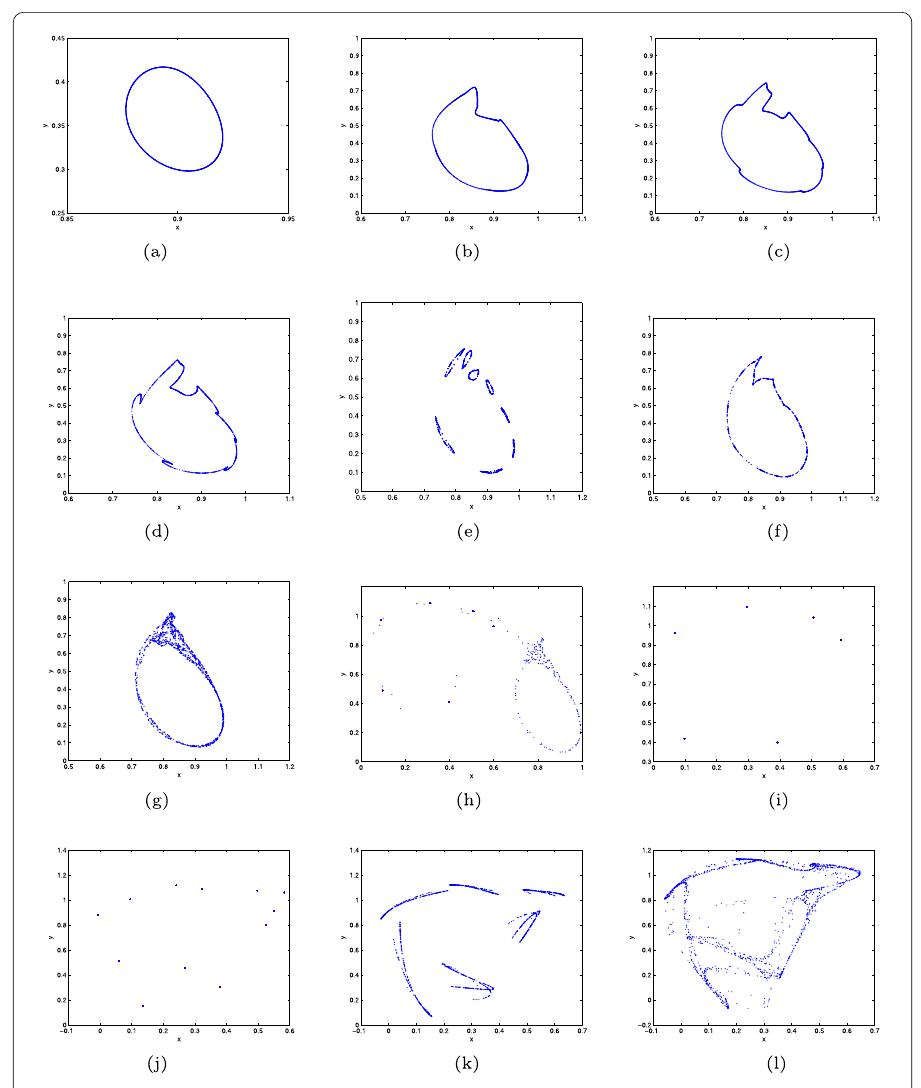
Figure 3 Phase portraits for different values of μ . ( a ) μ = 3.9517; ( b ) μ = 4.2863; ( c ) μ = 4.3091; ( d ) μ = 4.3243; ( e ) μ = 4.3471; ( f ) μ = 4.3851; ( g ) μ = 4.4079; ( h ) μ = 4.4383; ( i ) μ = 4.3547; ( j ) μ = 4.5068; ( k ) μ = 4.5220; ( l ) μ =